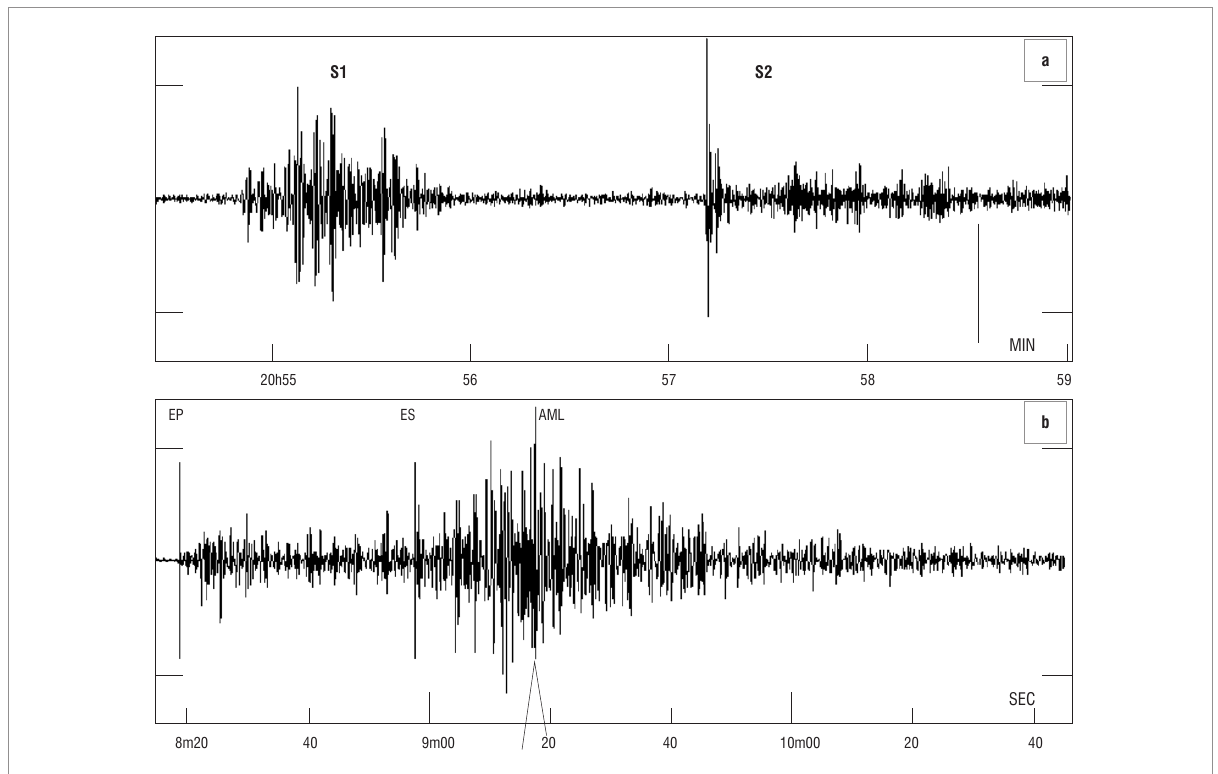
Figure 3: (a) Signal recorded at the Mussina station during the passage of a meteor on 21 November 2009. (b) Signal of a magnitude 3.2 earthquake originating in Mozambique recorded on 04 March 2009 at 17:08 (UT).